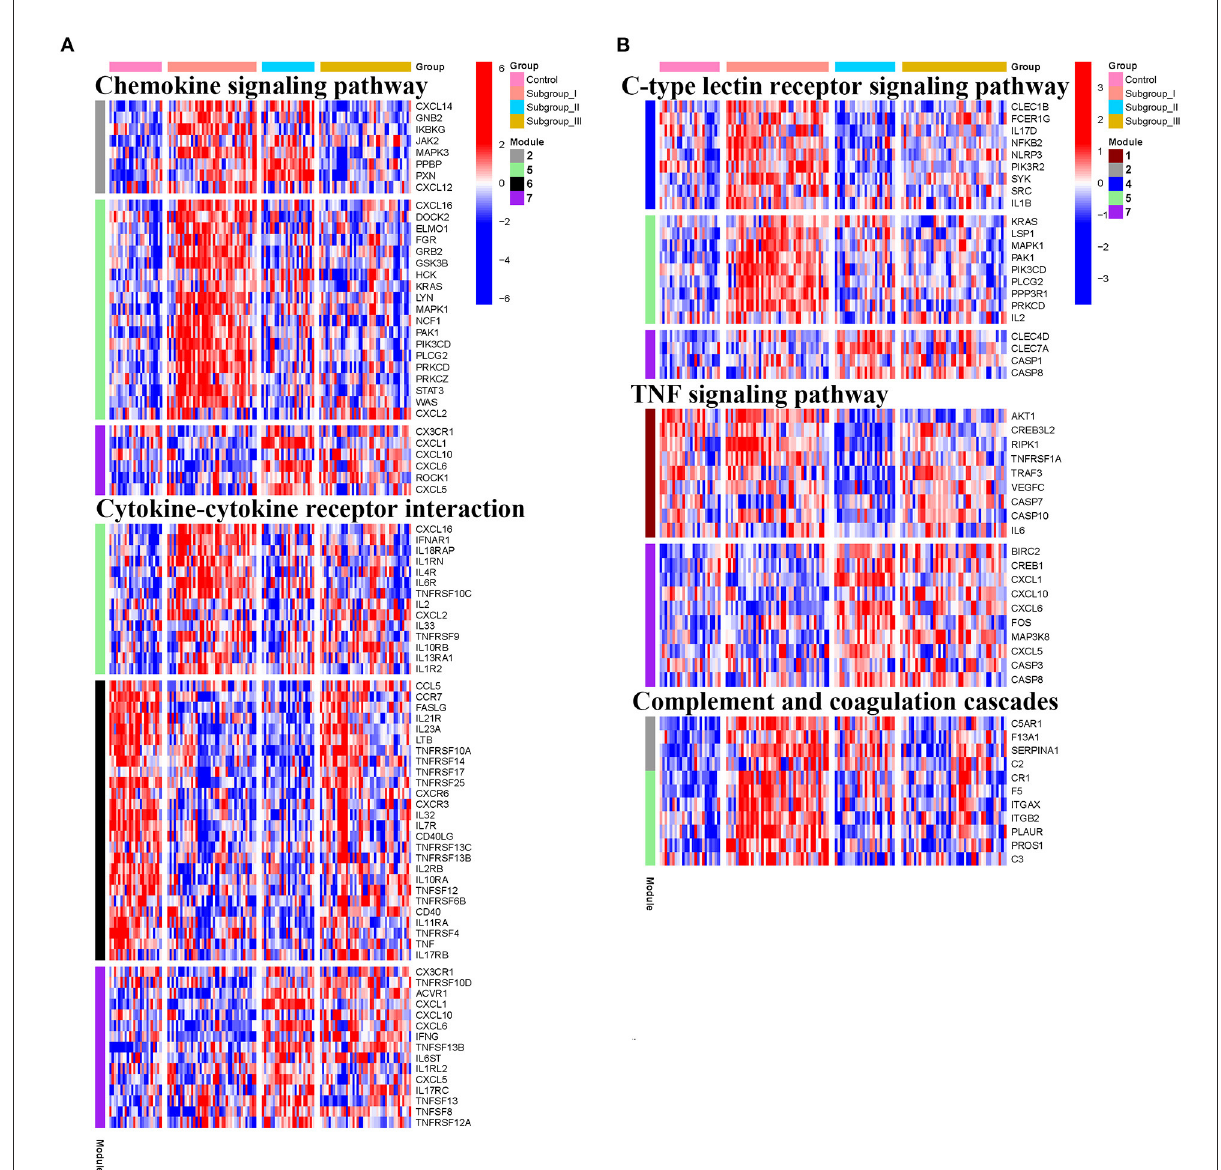
FIGURE8 Heatmap showing the scaled expression values of genes in representative subgroup-specific KEGG pathways related to inflammation and corresponding signature of each co-expression module among subgroups. (A) Chemokine signaling pathway and cytokine-cytokine receptor interation. (B) C-type lectin receptor signaling pathway, TNF signaling pathway, and complement and coagulation cascades. Heatmap colors correspond to the level of mRNA expression as indicated in the color